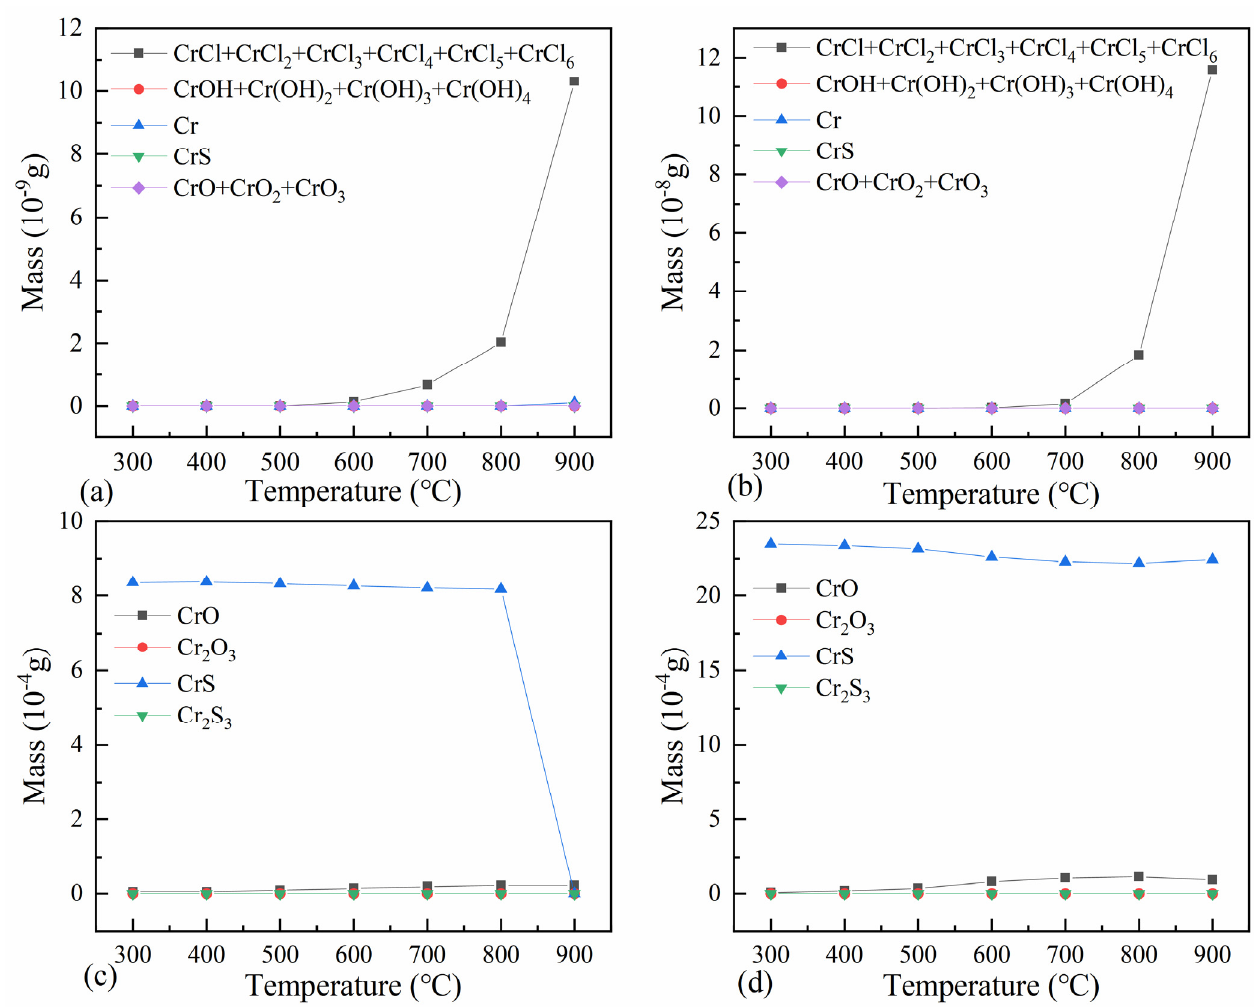
Figure 8. FactSage calculation results of Cr in NMH ( a , c ) and GL ( b , d ) coal.